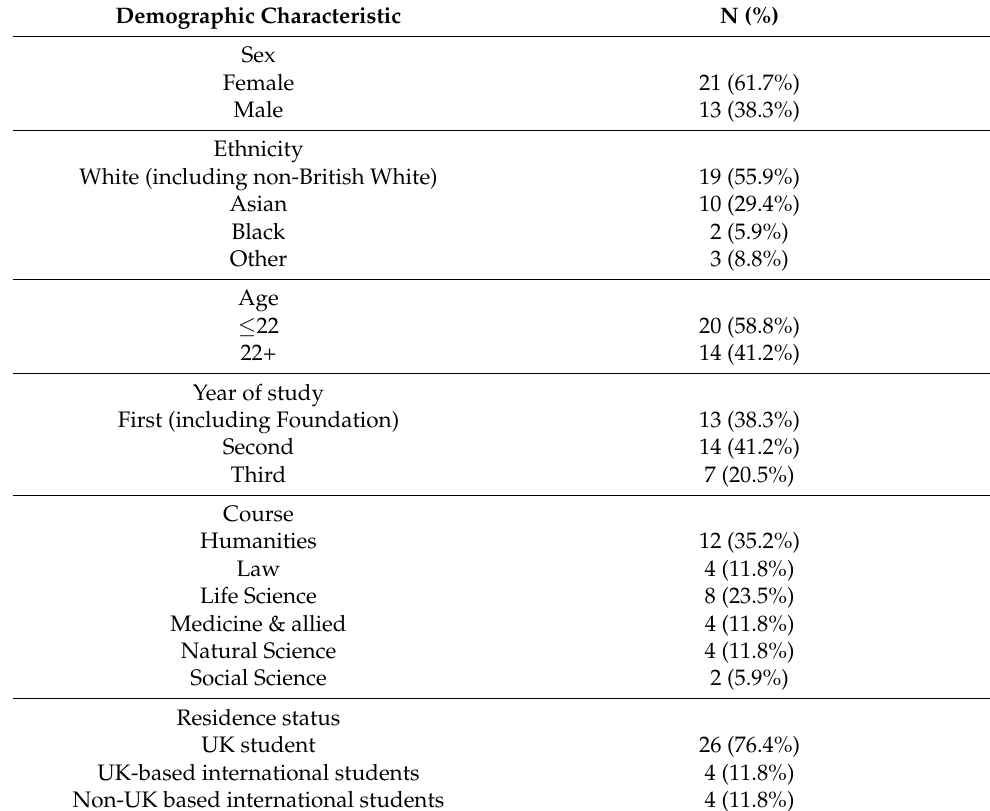
Table 1. Demographic characteristics of interview